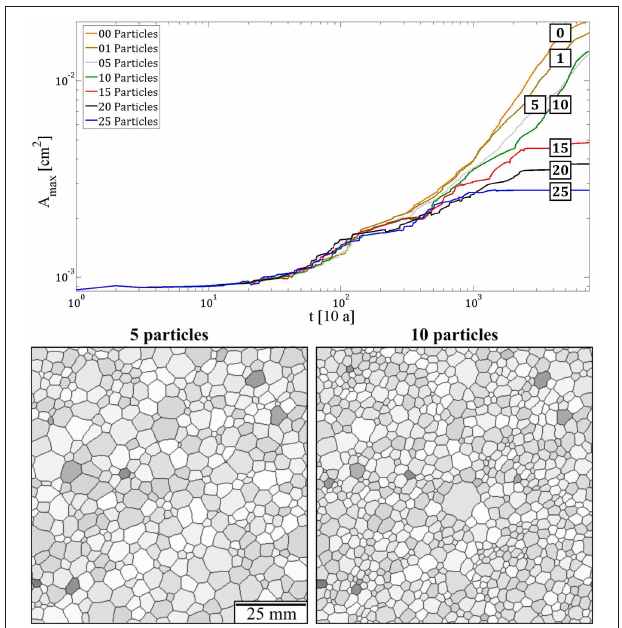
FIGURE 6 | Top: Graph showing the evolution of the maximum grain size during simulations of 7500 time steps. Bottom : The grain size distribution for the case of 5 and the case for 10 impurities per point in the hexagonal grid.